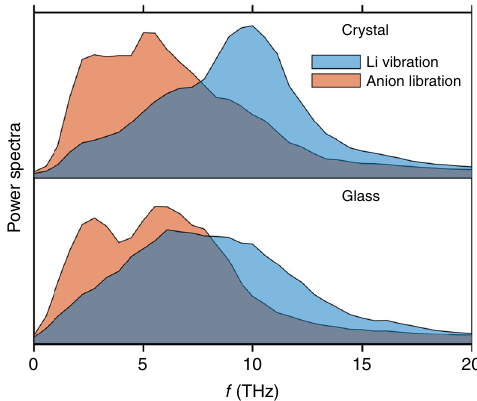
Fig. 5 Power spectra of the normalized velocity autocorrelation function for crystalline γ -Li 3 PS 4 (top) and glassy (bottom) Li 3 PS 4 at 300 K. Lithium vibrations are shown in blue, and anion librations appear in